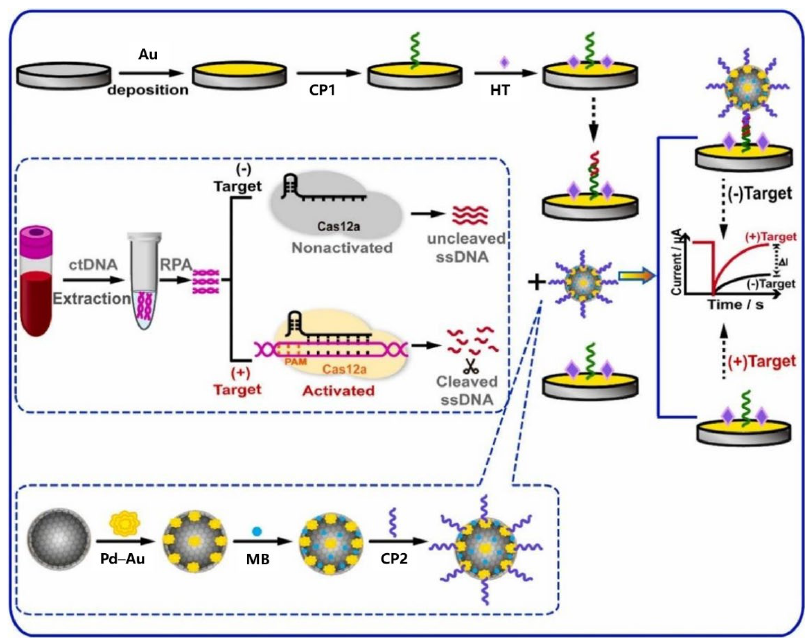
Figure 7. Schematic diagram of ctDNA electrochemical biosensor based on CRISPR/Cas12a (Re- printed with permission from Ref. [46]. 2022, Liu et al).